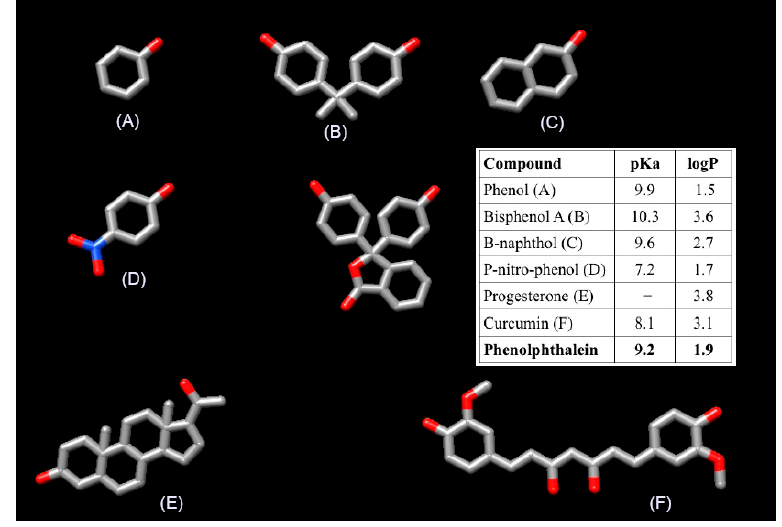
Figure 1. Structure and the features of the five compound ( A – F ) studied in our paper and the phenolphthalein used by Wilson et